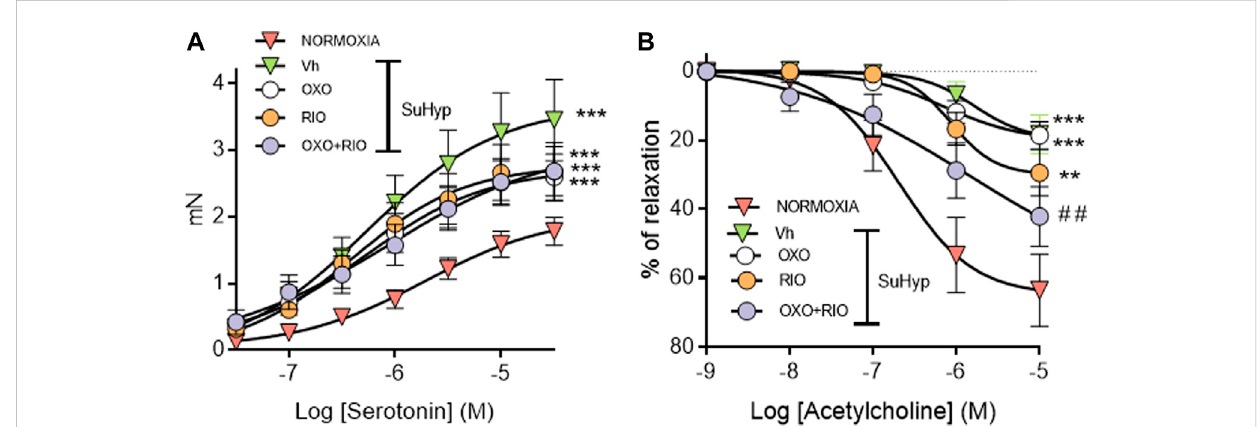
FIGURE 6 Riociguat plus 5-z-7oxozeaenol combination attenuates pulmonary endothelial dysfunction in rats with PH. (A) Contractile responses induced by serotonin is isolated intrapulmonary arteries from control (normoxic) rats and rats with PAH (SuHyp) treated with vehicle (Vh), 5-z-7-oxozeaenol (OXO), riociguat (RIO) or a combination of both drugs (OXO + RIO). (B) Concentration-dependent relaxant responses induced by the endothelium-dependent vasodilator acetylcholine in pulmonary arteries isolated from the different experimental groups. N = 12-15, * p < 0.05 versus normoxia and # vs. SuHyp + vehicle (two-way ANOVA followed by Bonferroni ’ s post hoc